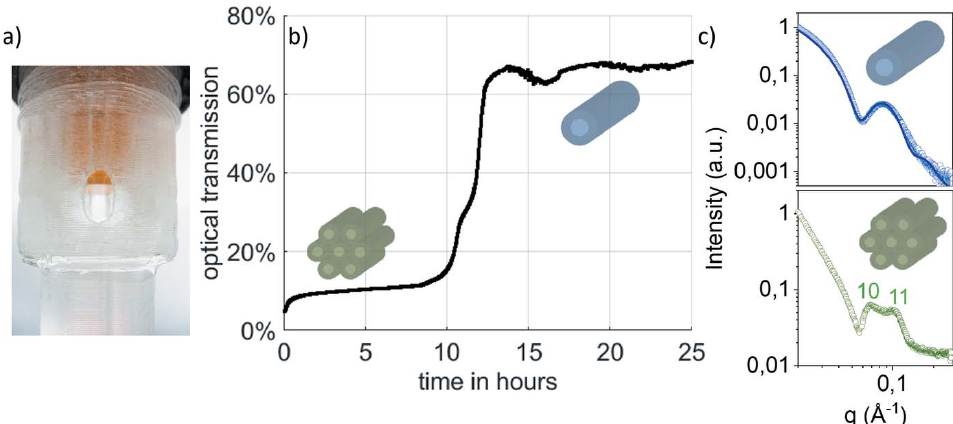
Figure 6 ( a ) Photograph of the X-ray chamber showing the optical transparent X-ray window and the dialysis insert (orange). ( b ) Optical turbidity across the X-ray chamber showing the structural transition from a condensed hexagonal to a dispersed cylindrical micelle phase. ( c ) In-house SAXS signal of hexagonal-packed (green) and monodispersed micellar rods (blue) in solution. Data were taken with 20 min exposure time each. The solid line corresponds to the spherical-core shell form factor (blue). Miller indices show first and second peaks for 2D hexagonal